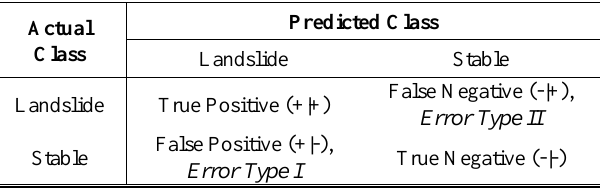
Table 1. Confusion matrix for performance